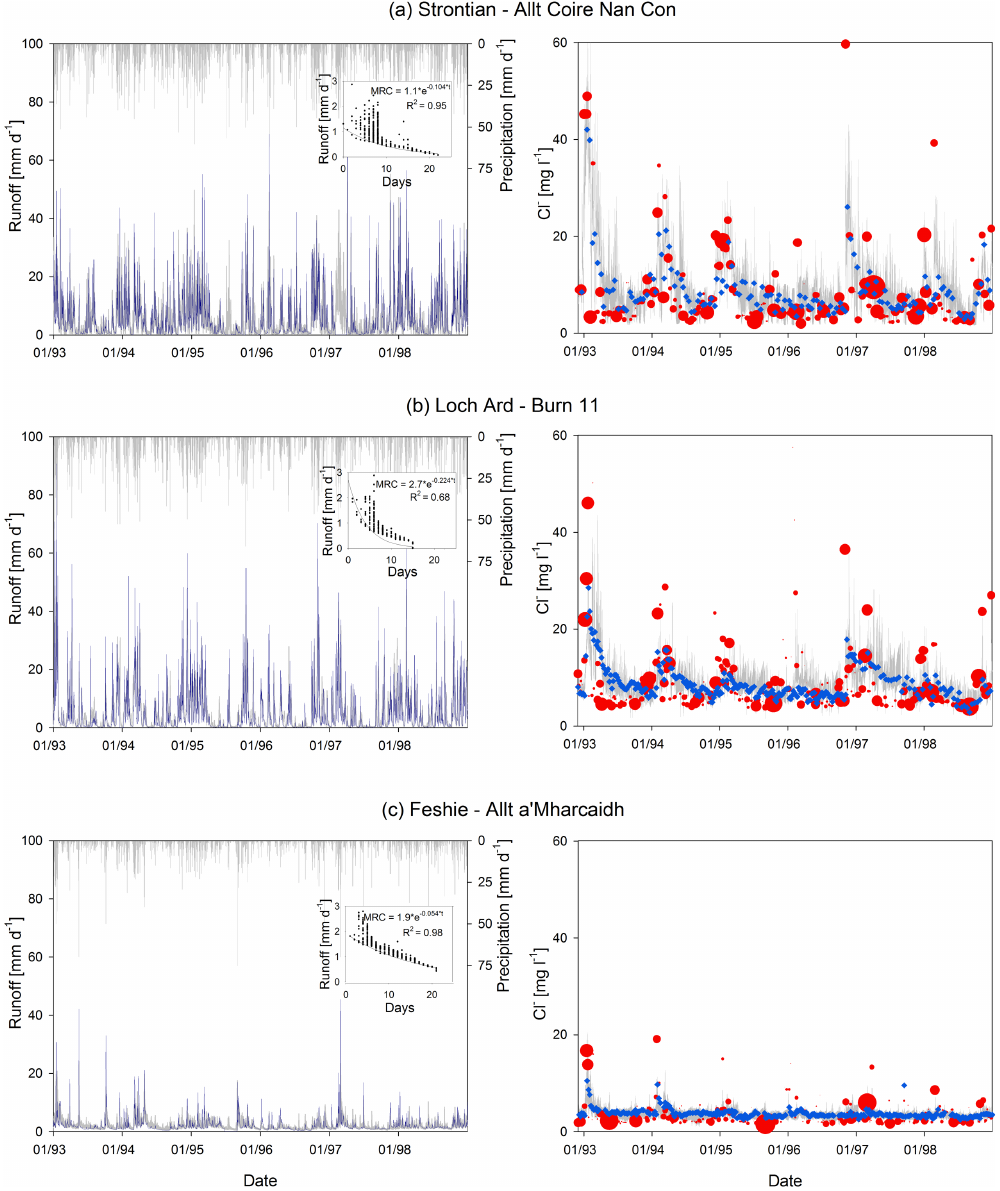
Fig. 2. Left column: time series of observed daily precipitation ( − ) and runoff ( − ) and modeled runoff ( − ) for a selected characteristic 5-yr period. The insets show the Master recession curves. Right column: time series of observed Cl − input (red dots) and output (blue dots) concentrations. The symbol size indicates the mass flux. The grey shaded area is the 95% uncertainty interval of the modeled stream concentration using all pareto optimal